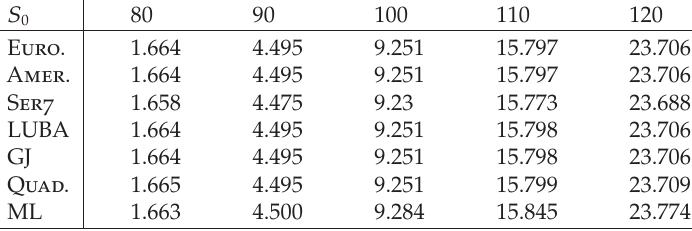
Table 2.5 . Call: Comparison with other methods; τ = 0 . 5, E = 100, r = 0 . 07, D = 0 . 03, σ = 0 . 3. Euro. and Amer. are values of Euro- 0 pean and American options computed using a 100,000 step bino- mial tree. Ser7 is the value of an American option computed using a 100,000 path Monte Carlo simulation taking 7 terms in series ( 1.3 ) as the exercise boundary. LUBA is the LUBA approximation ( Broadie and Detemple [ 17 ]) . GJ is the ( 2-point ) Geske-Johnson approxima- tion ( Geske and Johnson [ 33 ]) . Quad. is the quadratic approximation ( MacMillan [ 41 ] ; Barone-Adesi and Whaley [ 8 ]) . ML is the method of lines based on n = 3 time steps ( Ju [ 38 ]) .